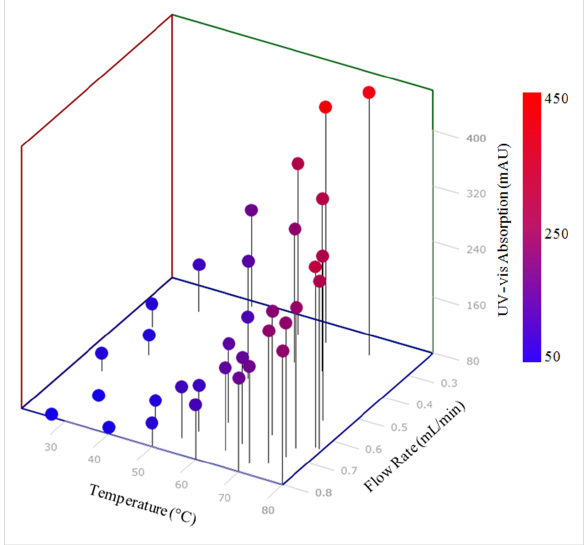
Figure 5: Optimisation plot for the SIMPLEX optimisation of semicar- bazone 2 . Optimum reaction conditions within the specified system were found to a flow rate of 0.27 mL/min and a temperature of 69